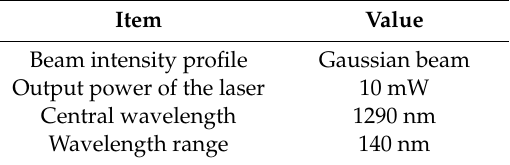
Table 1. The conditions under which the simulations were carried out.